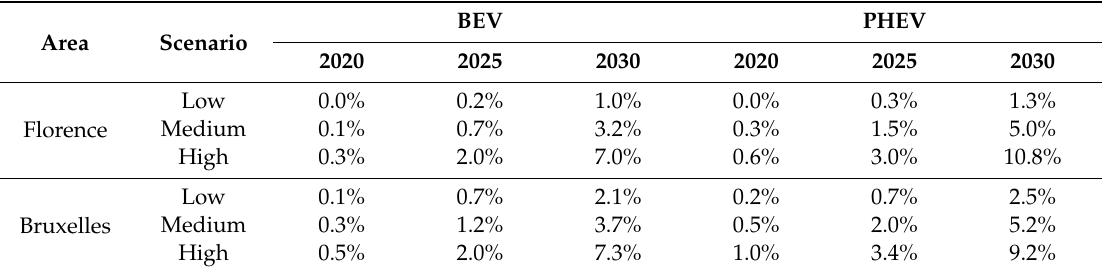
Table 5. BEV and PHEV fleet forecasts for the area of Florence and Bruxelles municipalities—shares of total circulating fleet.